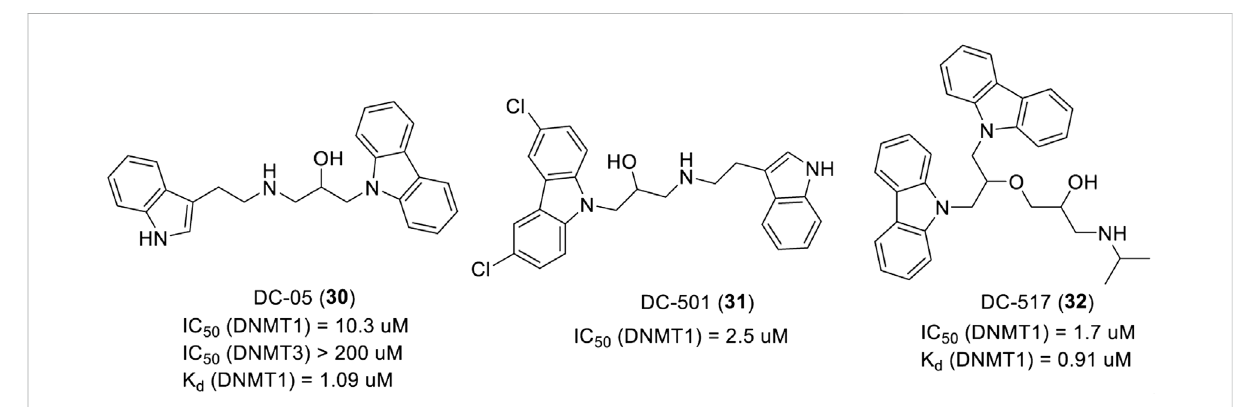
FIGURE 7 Chemical structure of carbazole-based DNMTis in